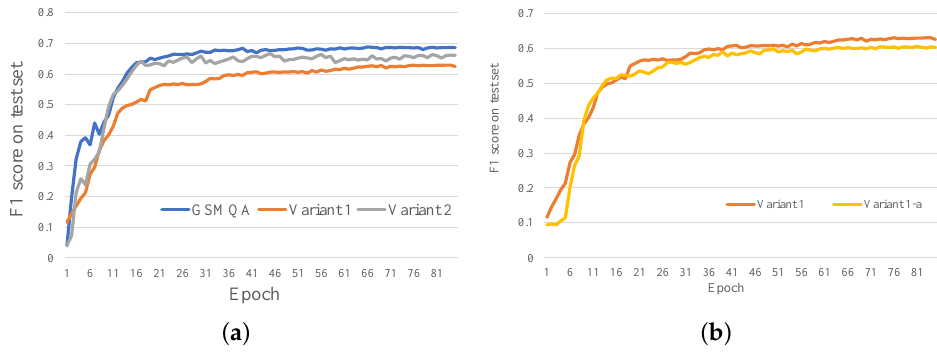
Figure 5. Comparison of the F1-score for each variant. ( a ) Comparison of our method and its variants. ( b ) Comparison of variant 1 and its